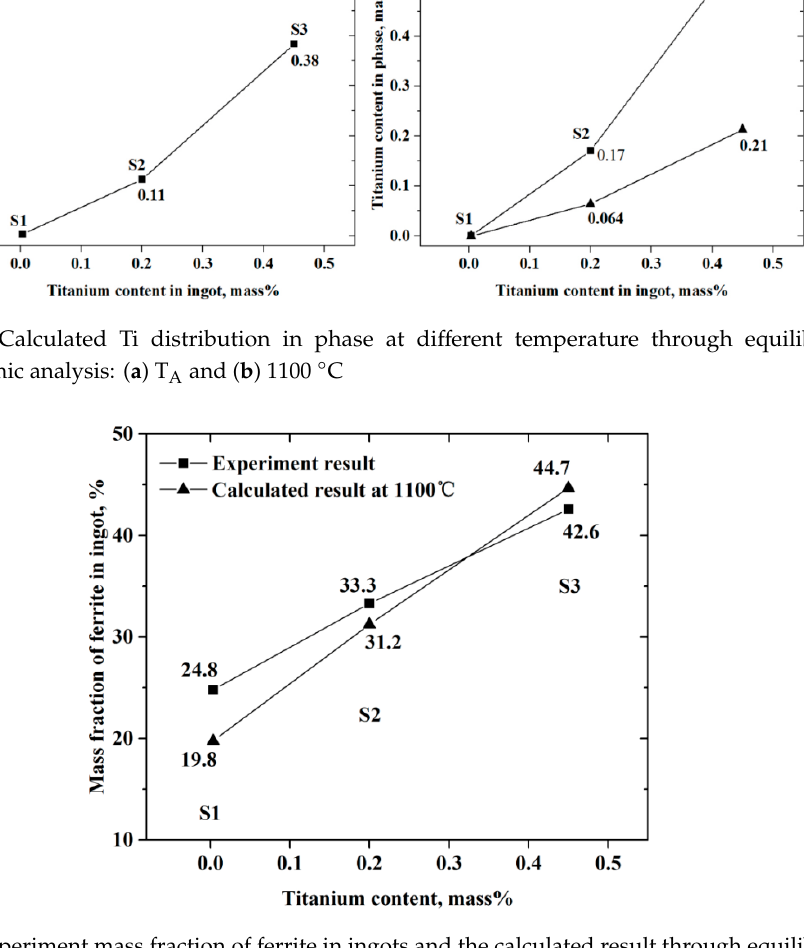
Figure 16. Experiment mass fraction of ferrite in ingots and the calculated result through equilibrium thermodynamic analysis.